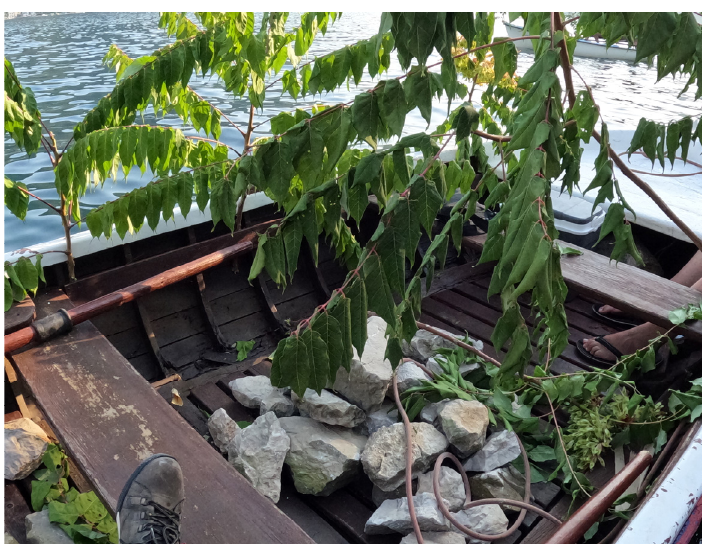
Figure 3. Stones and branches on the boat in 2022. Photo by author.